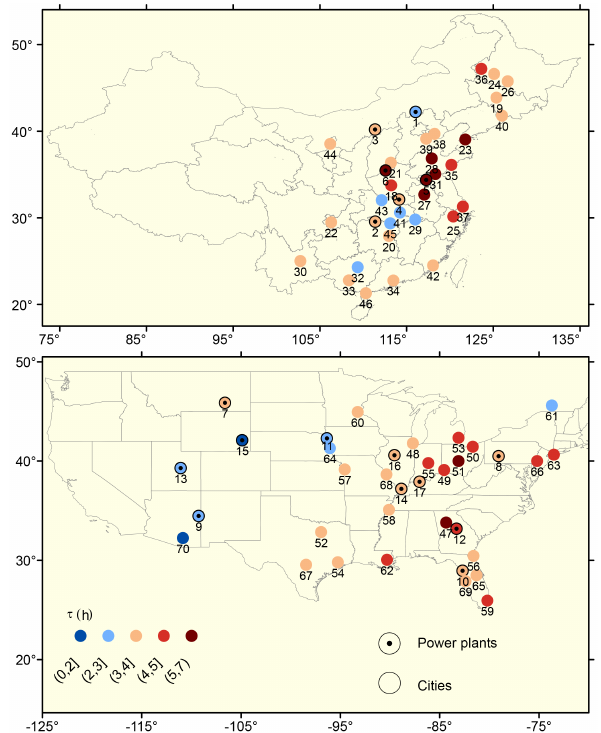
sion sources over China and the USA. Locations of power plants are indicated by dots. Power plants and cities are labeled by their IDs (see Table